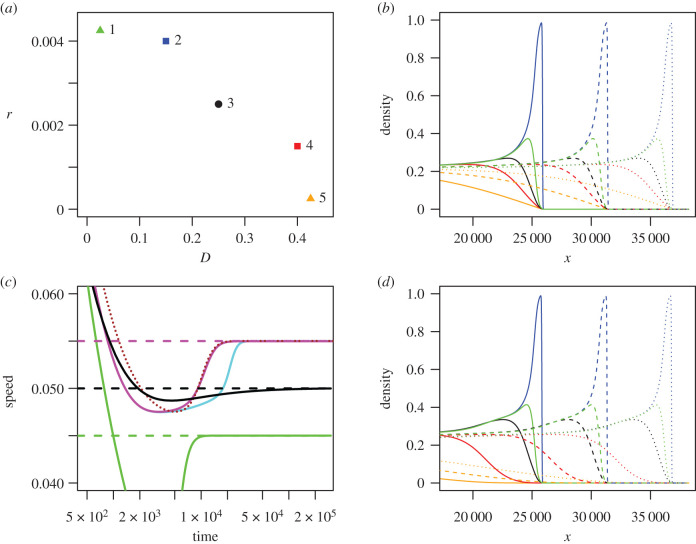
Anomalous invasions by polymorphic species into unoccupied habitat, where all strains can coexist at equilibrium, from numerical solutions of equation (2.1). Panel (a): trait values for five strains used in this figure. (Di, ri) = (0.025, 0.00425), (0.15, 0.004), (0.25, 0.0025), (0.4, 0.0015), (0.425, 0.00025) for strains i = 1, 2, 3, 4, and 5, respectively. Squares denote the ‘vanguard’ strains (2 and 4) and triangles the ‘extreme’ strains with the highest growth rate (strain 1) and highest dispersal ability (strain 5), respectively. Strain 3 (circle) has the highest monomorphic speed. Colours correspond to those used in (b,d) (green, blue, black, red, and orange for i = 1, 2, 3, 4, 5, respectively). (b,d) Population density as a function of spatial coordinate x during invasion by a species consisting of all five strains, displaying travelling waves, at times t = 4 × 105 (solid curves), 5 × 105 (dashed curves), 6 × 105 (dotted curves). Mutation is universal among strains (νij=1∀i,j) in panel b, but in panel d is only non-zero between neighbouring strains (νij = 1 if |i − j| = 1, 0 otherwise). (c) Speed of position of front for species consisting of different combinations of strains. Magenta: all five strains present, universal mutation. Cyan: all five strains present, neighbouring-strain mutations only. Brown dotted curve: vanguard strains (2 and 4) only. Black: strain 3 (fastest monomorphic speed) only. Green: extreme strains (1 and 5) only. Dashed horizontal lines are theoretical predictions for μ → 0: c=c24d=0.055 (magenta); c=c3m=0.05 (black); c=c15d=0.045 (green). In all cases, mutation rate μ = 10−6, and competition coefficients are Cij = 1 for i = j, 0.9 otherwise.